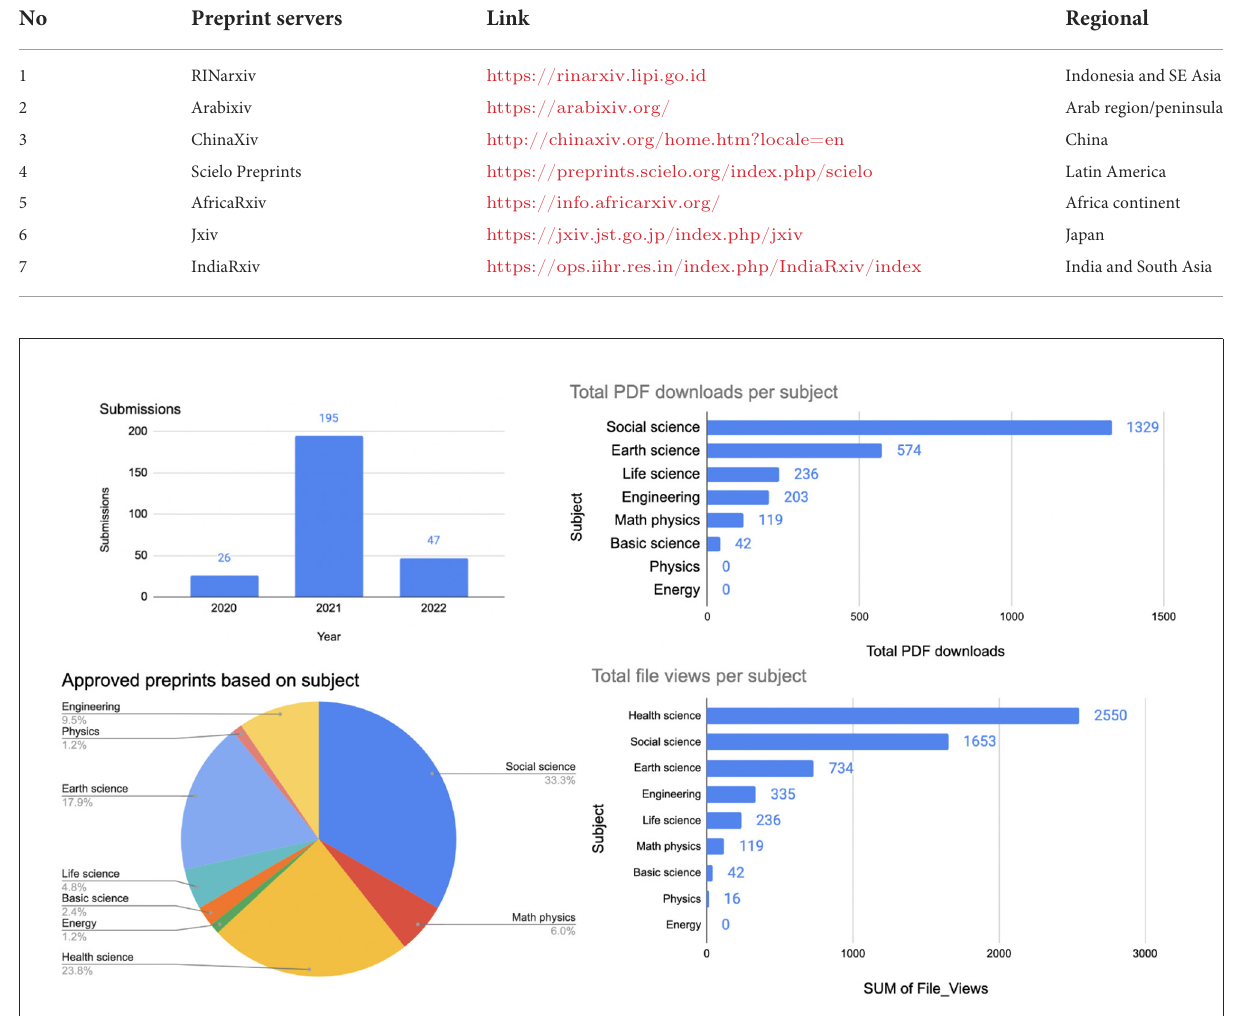
FIGURE1 RINArxiv infographic from May 21, 2020 until June 30,